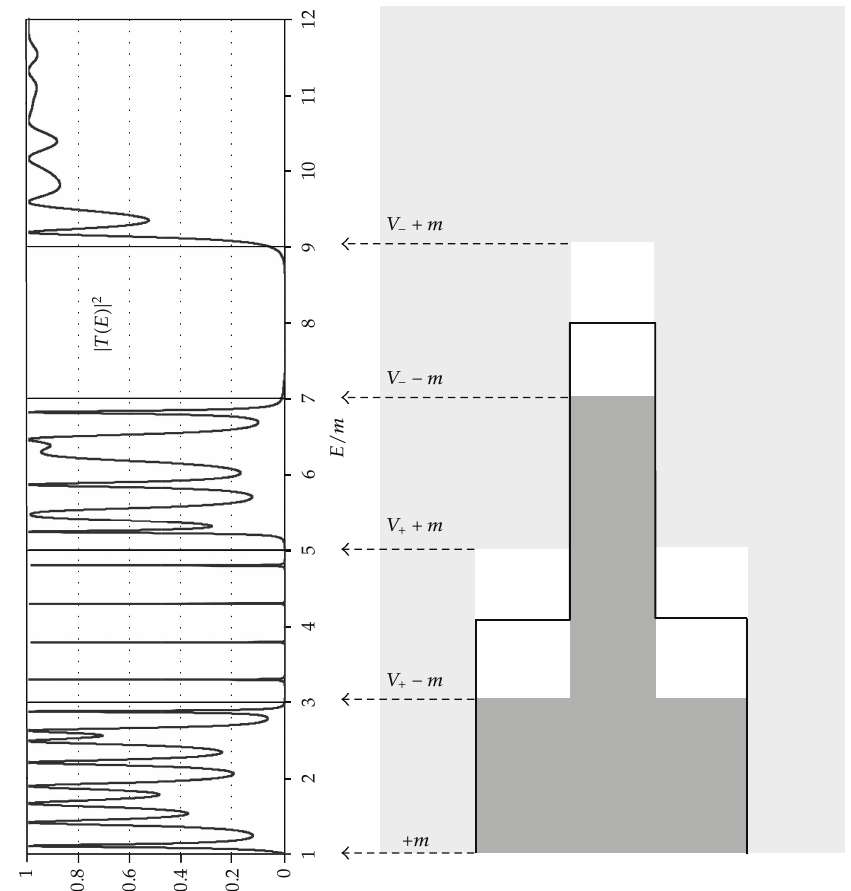
Figure 8: We combine Figures 6 and 7 together in such a way that Figure 7 is turned 90 degrees such that the energy axis of Figures 6 and 7 coincide. In this way, one can clearly see how the di ff erent transmission regions correspond to the di ff erent potential